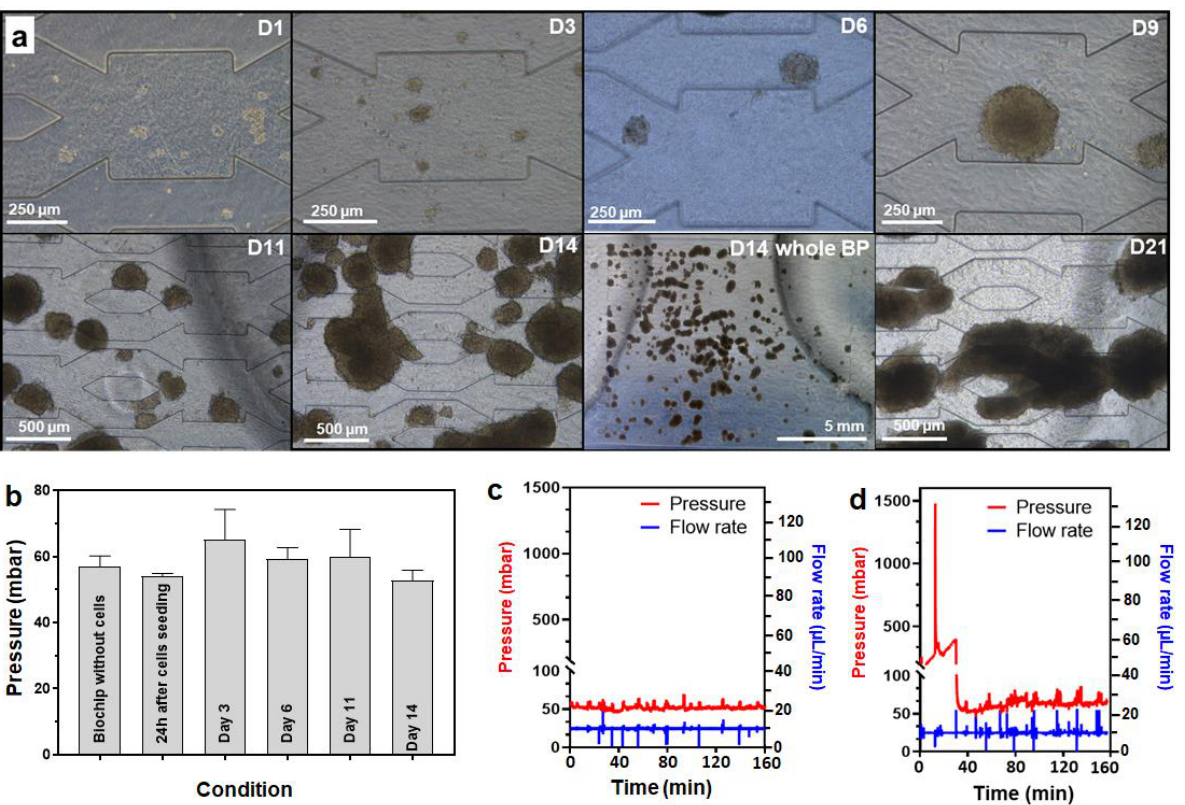
Figure 6. Long-term (21 days) culture of HepG2/C3A cells in a biochip with a hydroscaffold (Starting cell density of 20,000 cells/cm²). ( a ) evolution in the morphology of HepG2/C3A spheroids throughout the 21 days of culture; ( b ) pressure evolution during the first 14 days of culture; ( c , d ) pressure measured inside the biochip on day 14 and 21, respectively.